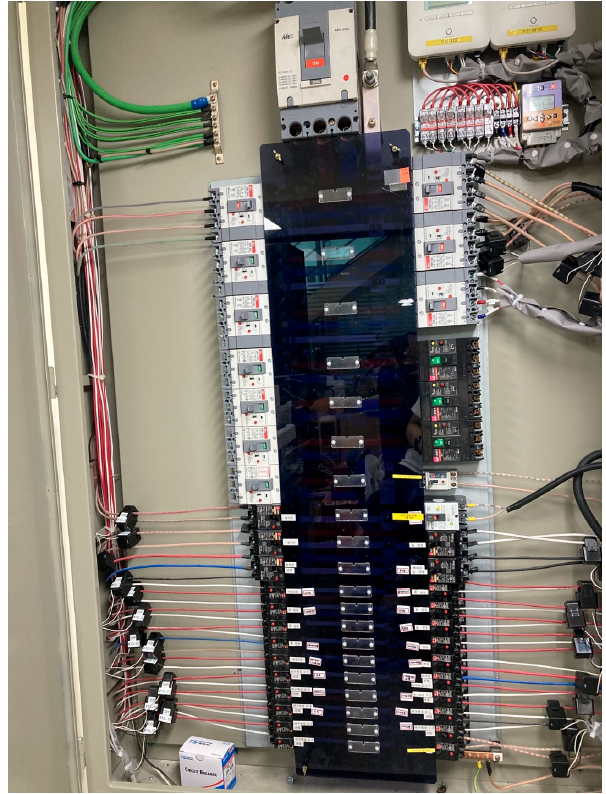
Figure 5. Smart meter installed for energy consumption data collection.